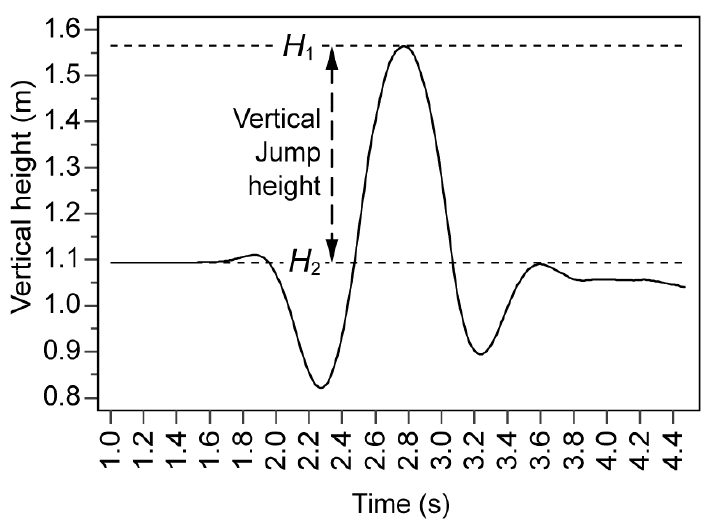
Figure 1. Determination of jump height from the data obtained by the MoCAP system by the difference between the initial height ( H 2 ) and the highest point registered ( H 1 ).